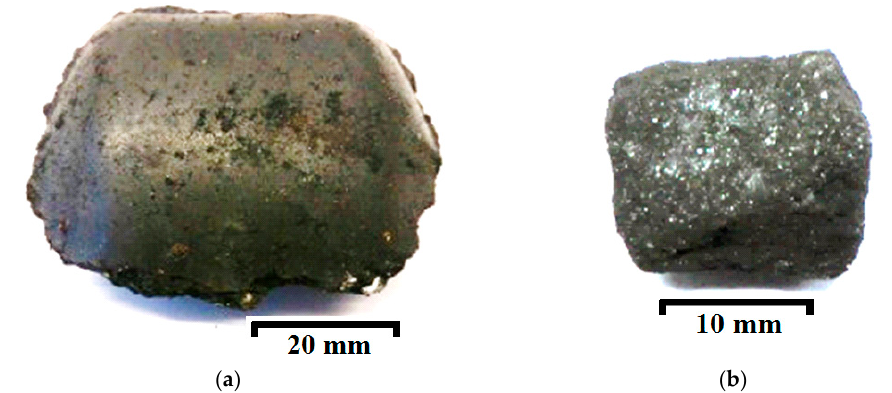
Figure 1. Typical images of an industrial briquette ( a ) and a briquette sample used in the thermo-gravimetric reduction (TGR) experiments ( b ).